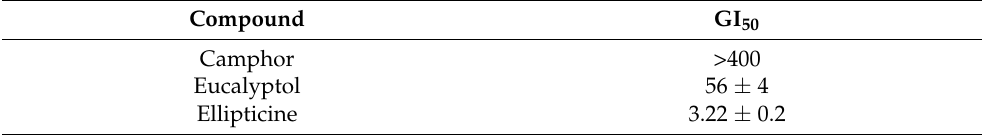
Table 2. Cytotoxicity of camphor and eucalyptol (mean ± SD). GI 50 values ( µ g/mL) corresponding to the sample concentration achieving 50% of growth inhibition in liver primary cultured PLP2